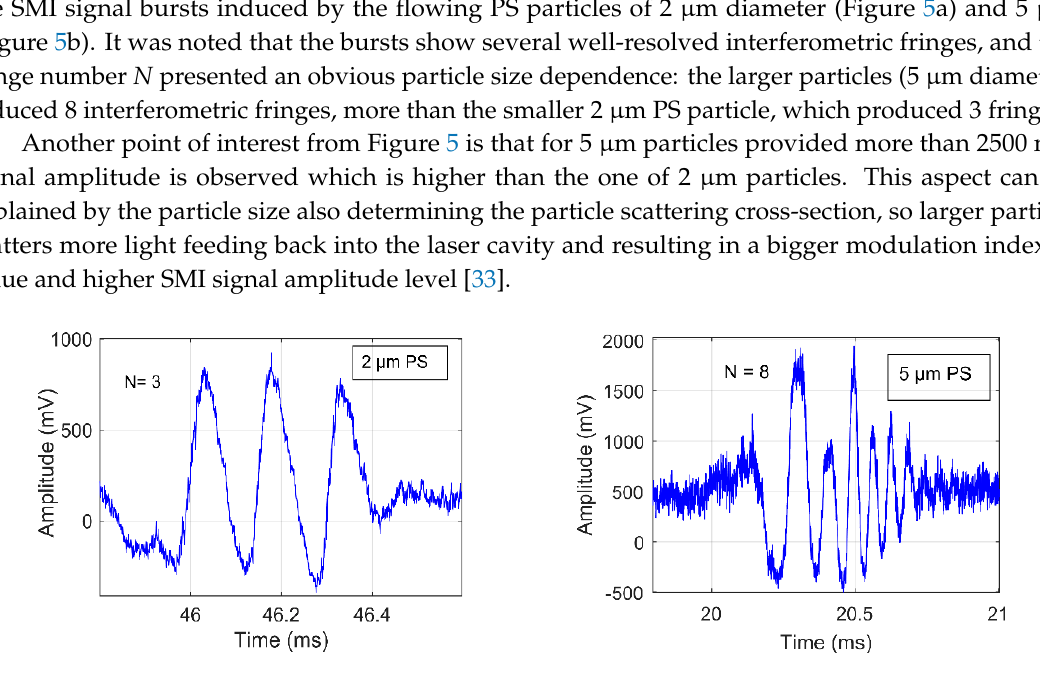
Figure 5. The SMI signal bursts polystyrene sphere (PS) particles in ( a ) 2 μm diameter ( b ) 5 μm diameter.